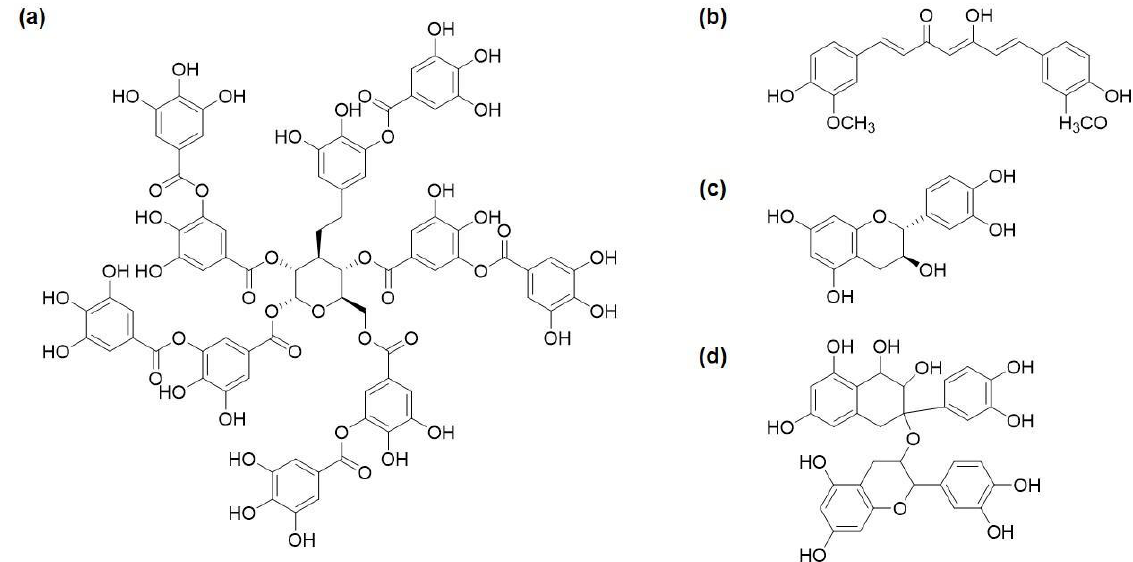
Figure 10. Chemical structures of antimicrobial polyphenols such as ( a ) TA, ( b ) curcumin, ( c ) catechin, and ( d ) procyanidin.